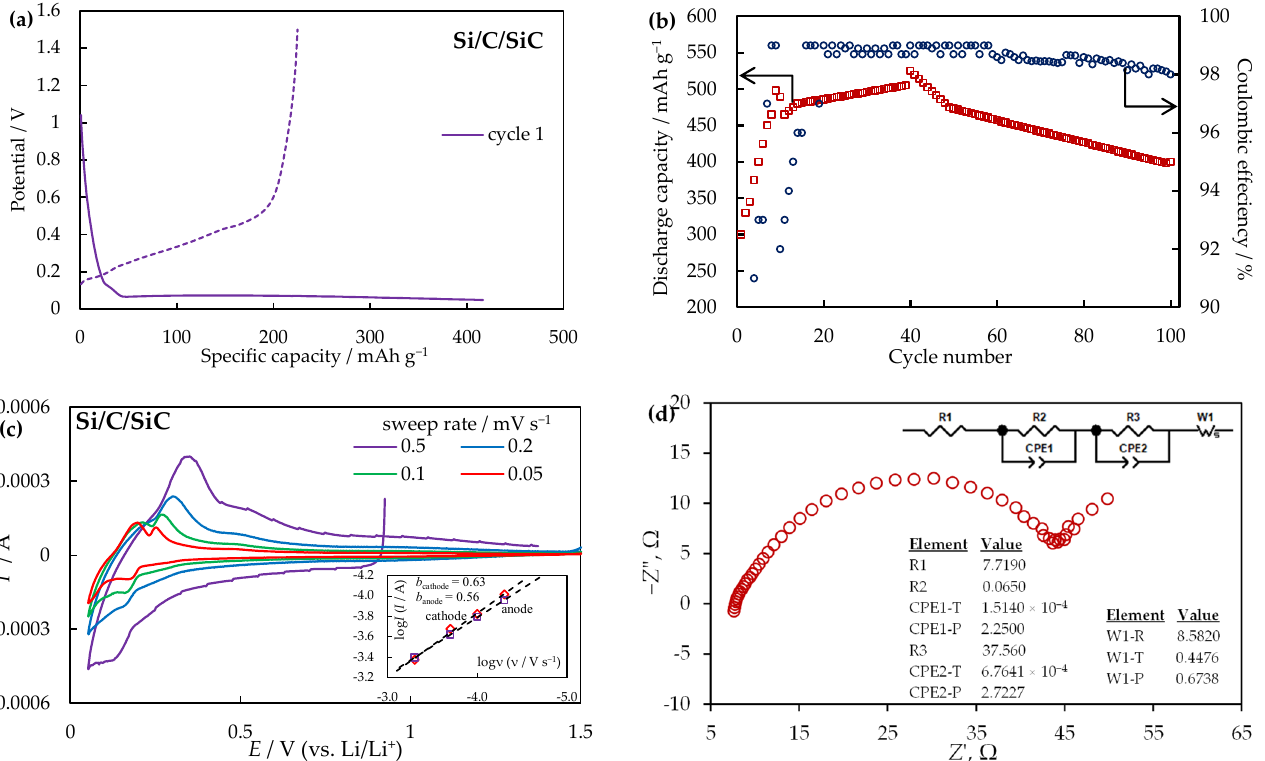
Figure 9. Cycling of Si/C/SiC electrode: ( a ) potential change during first cycle lithiation (dashed line) and delithiation (solid line); ( b ) discharge capacity and Coulombic efficiency; ( c ) CVs at different scan rates and log( I )–log( ν ) dependencies; ( d ) EIS data with equivalent circuit diagram.